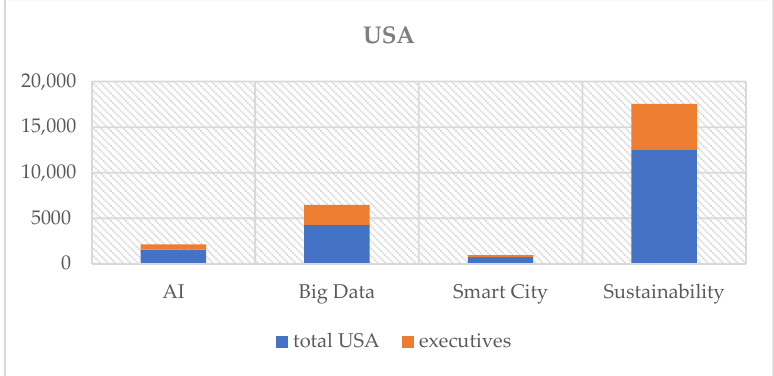
Figure 3. The number of job offers in the energy sector in the United States with selected skills required: the total number and the number of job posts for executives.